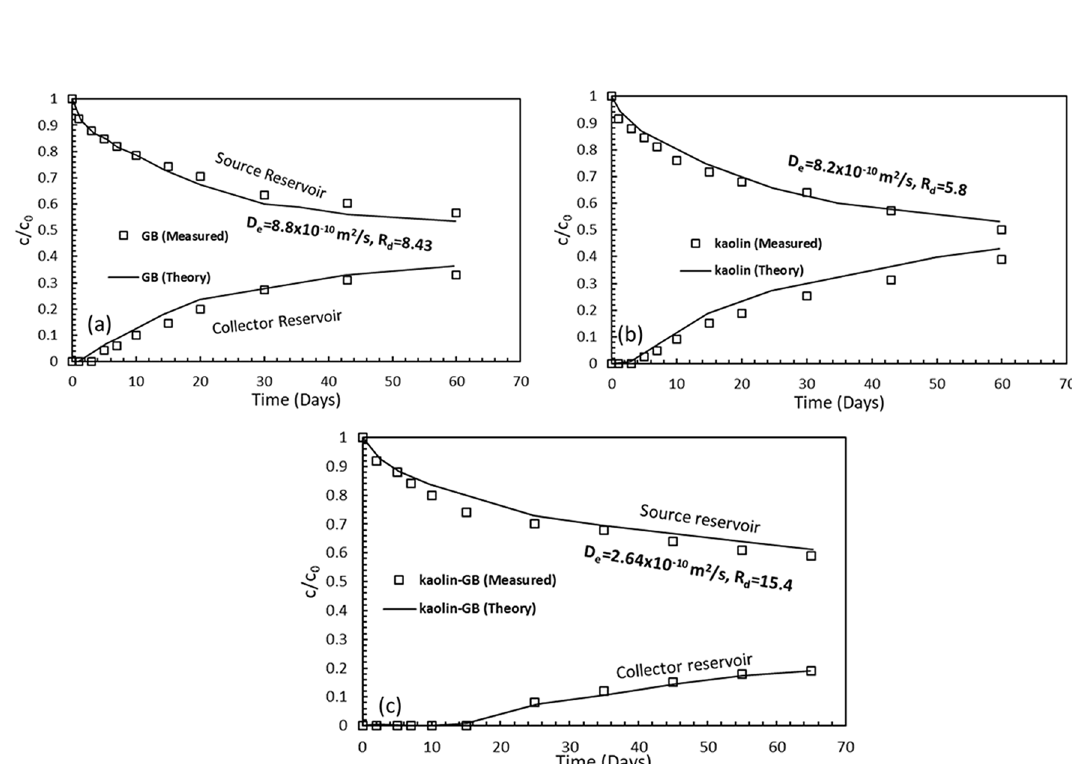
Figure 5. Comparison of the measured and theoretical concentration data in the presence of 0.5 M KCl for the ( a ) GB layer, ( b ) kaolin layer, and ( c ) kaolin-GB layered